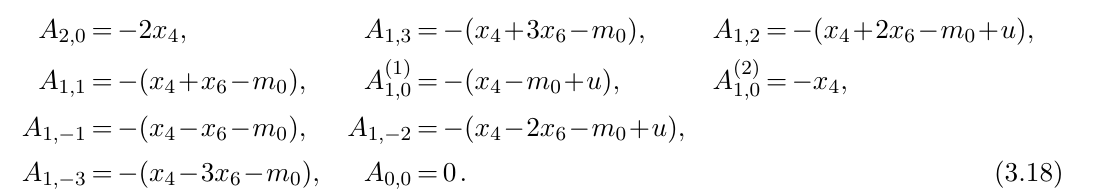
m 0 for m 0 0 and u = 0 3 (cid:20)